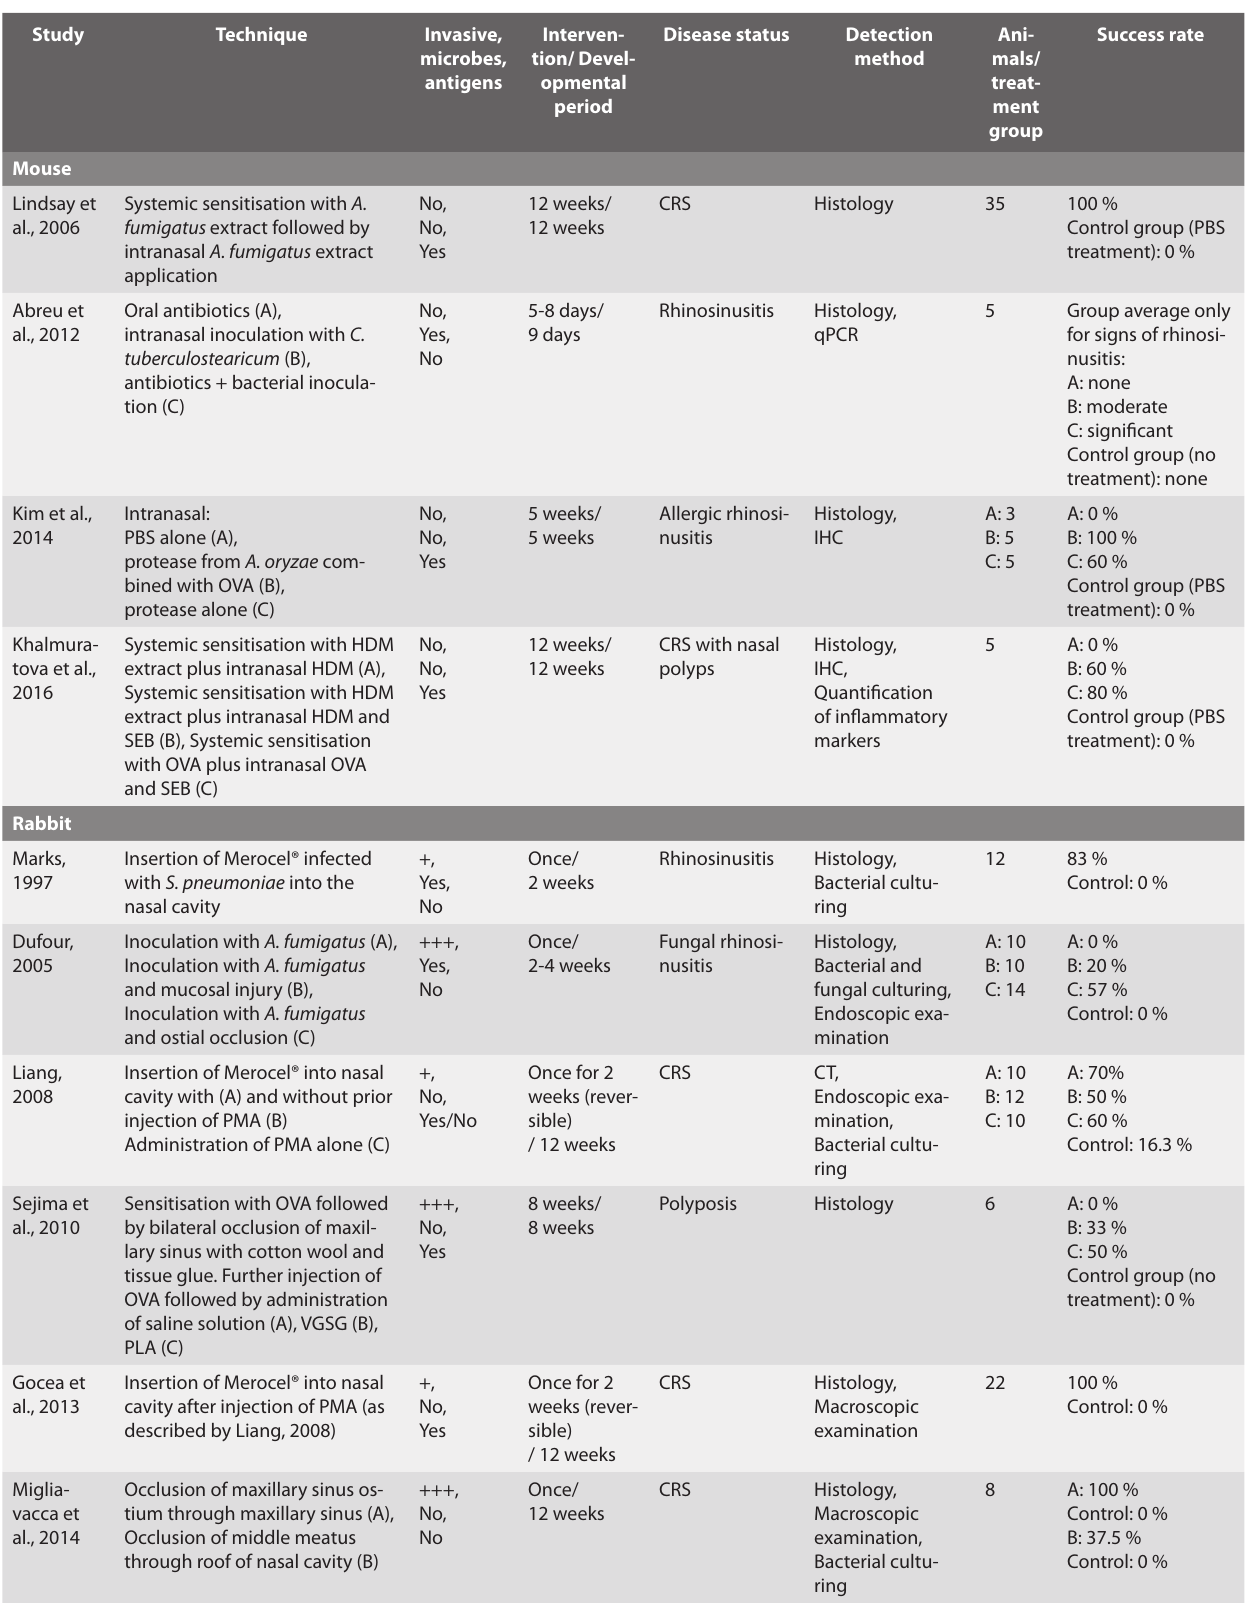
Table 1. A selection of previously used animal models of CRS and rhinosinusitis.